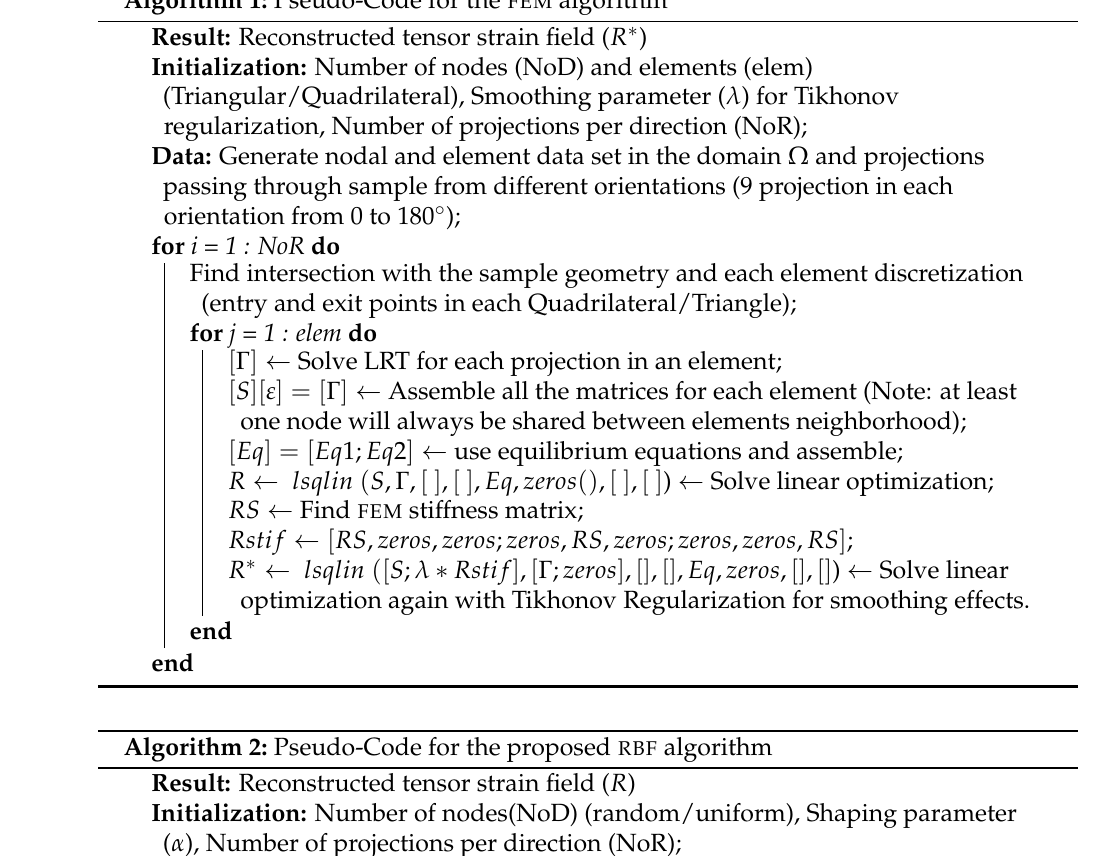
Algorithm 1: Pseudo-Code for the FEM algorithm